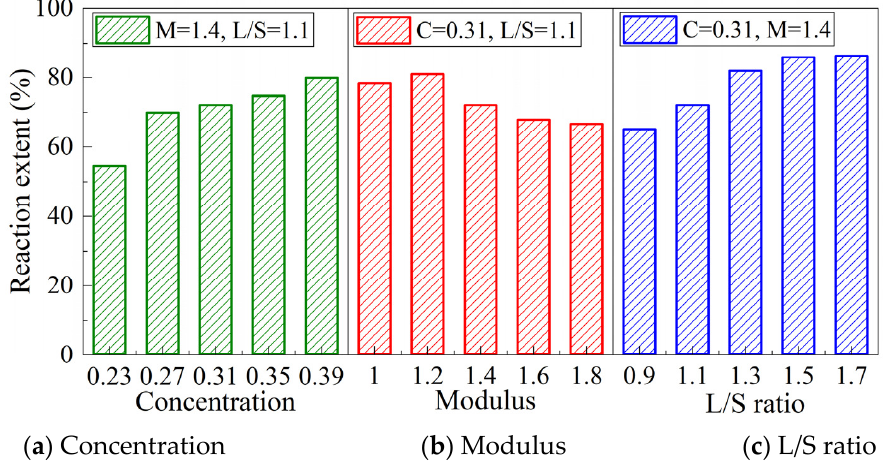
Figure 2. Reaction extent of MK-GGBFS geopolymer pastes with varying concentrations ( a ), moduli ( b ), and L/S ratios ( c